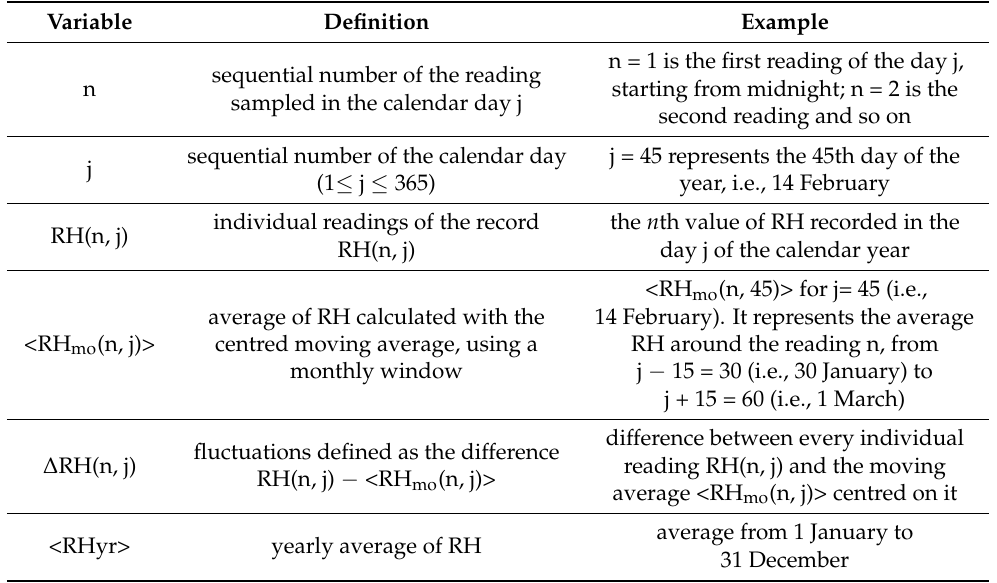
Table 2. Key variables used in the informative Annex A of EN